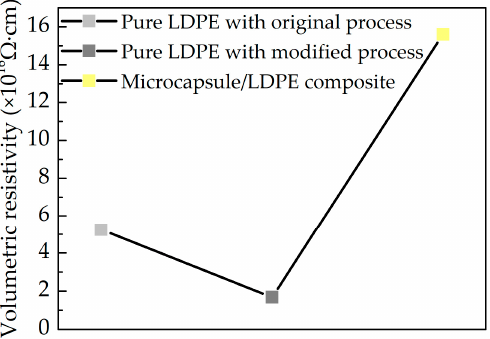
Figure 7. Volume resistivity of the samples.